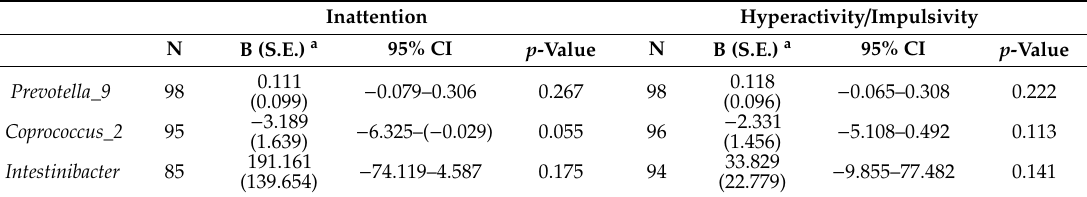
Table 3. Association of the genera with ADHD symptoms scores.